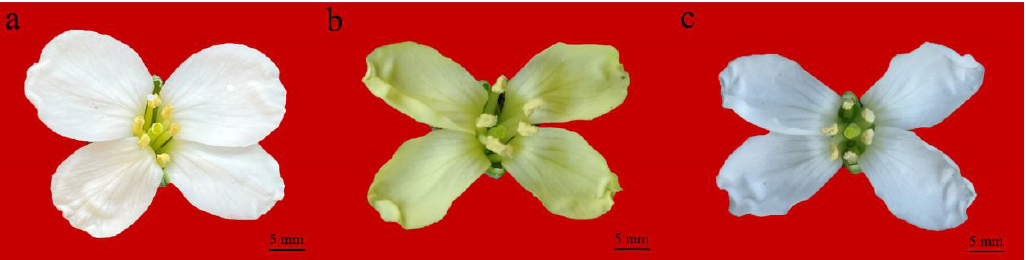
Figure 1. Phenotypes of A192-1, YL-1 and YF-2. ( a ) A192-1 with white petals. ( b ) YL-1 with yellow petals. ( c ) YF-2 with white petals. Bar = 5 mm.